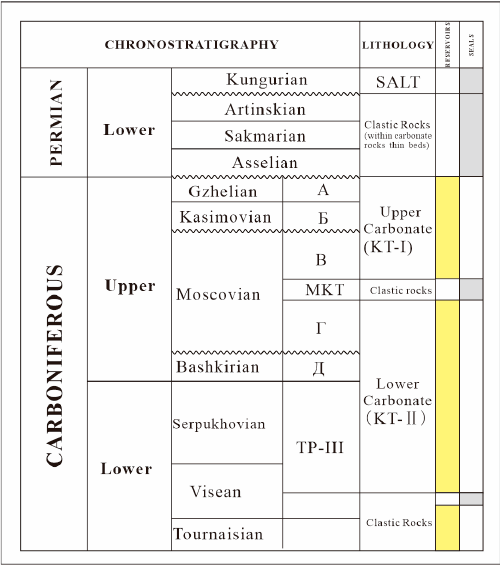
Figure 6. Regional stratigraphy in the study area.